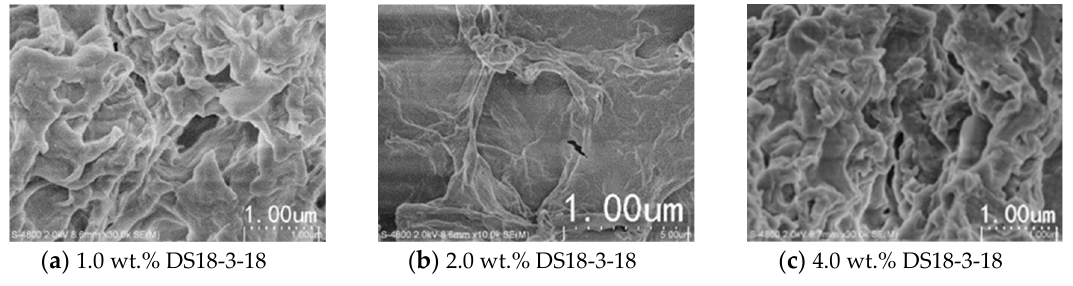
Figure 6. Effect of concentration on micelle structure of DS18-3-18.